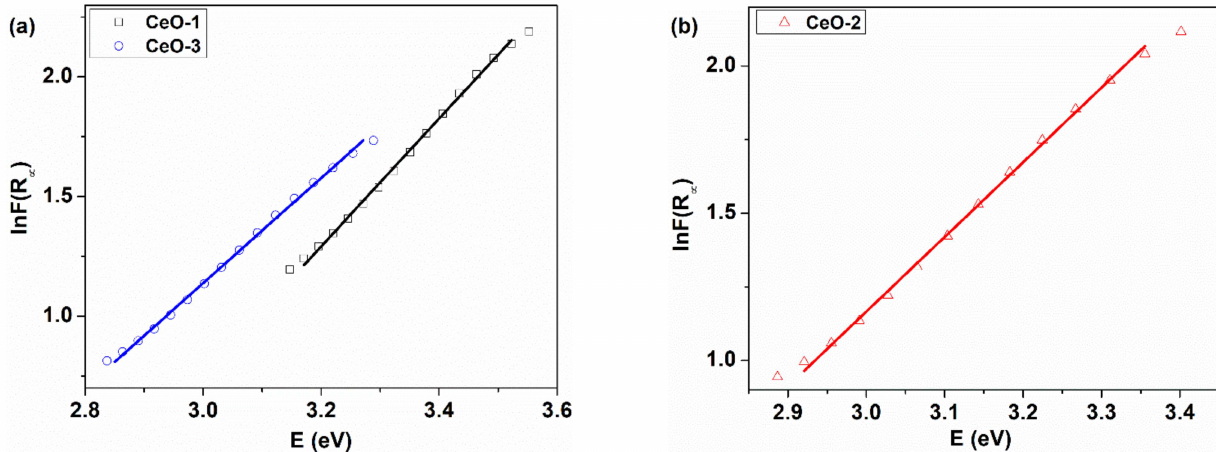
Figure 8. Urbach energy curves for cerium oxide nanoparticles: ( a ) CeO-1 and CeO-3, ( b )